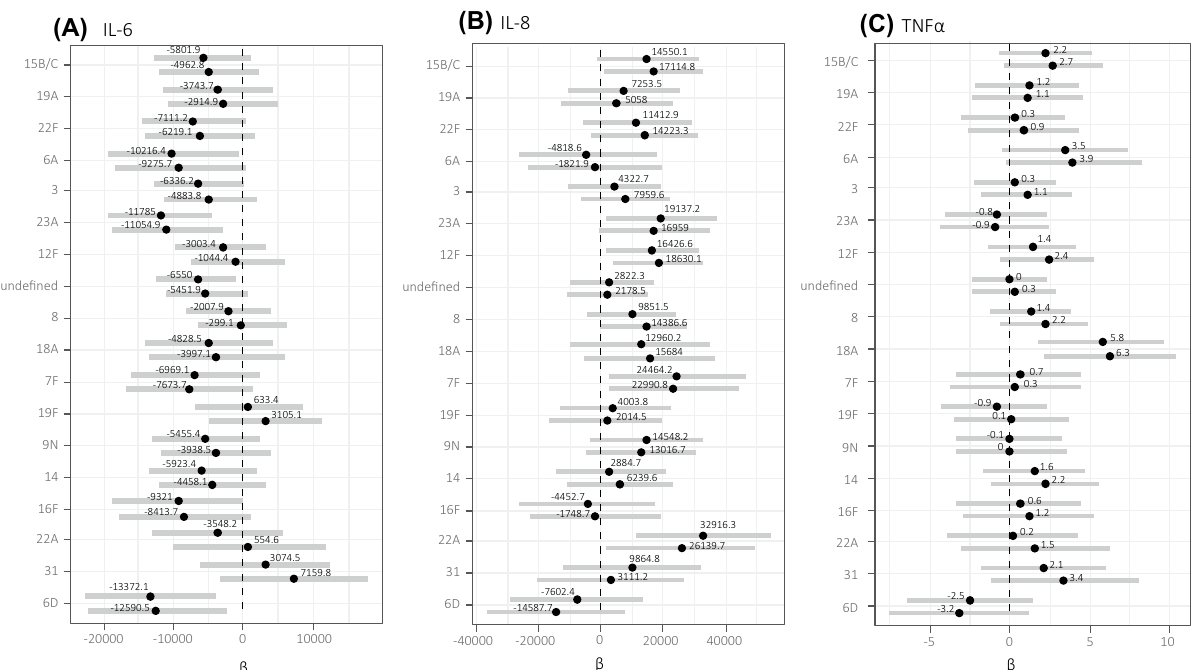
Figure 1. Serotypes associated with varying concentrations of ( A ) IL-6, ( B ) IL-8 and ( C ) TNF-α in cerebrospinal fluid (South African meningitis patients, 2018–2019). The 90% highest density intervals (HDI) of the posterior distributions of the estimated regression coefficients (β) are depicted as horizontal bars and dots indicate their medians, for both unadjusted (upper bars) and adjusted (lower bars; covariables HIV status and patient age) full Bayesian multivariable linear regression models. Serotypes are sorted from top to bottom in decreasing risk of case fatality. Serotype 10A was chosen as ad-hoc reference, for which β was set to 0. TNF-α concentrations were log-transformed to conform to normality prior to analysis. n = 57. This figure was generated using R (R Core Team (2019)). R: A language and environment for statistical computing. R Foundation for Statistical Computing, Vienna, Austria. https:// www.R- proje ct.